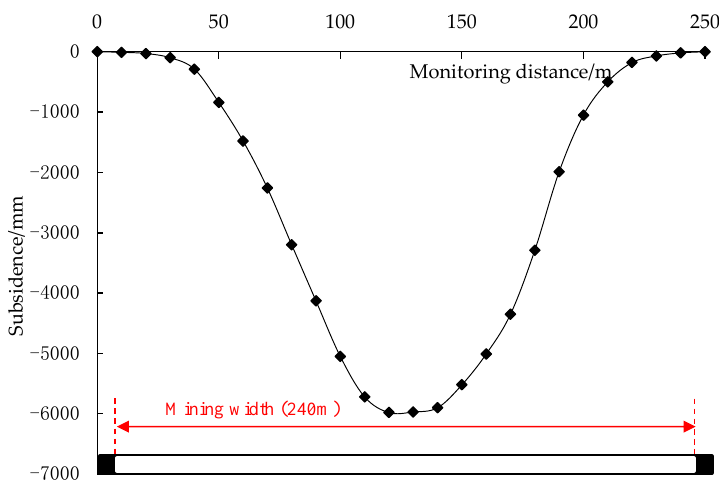
Figure 12. Sketch of the mining induced fractures and bed separation.